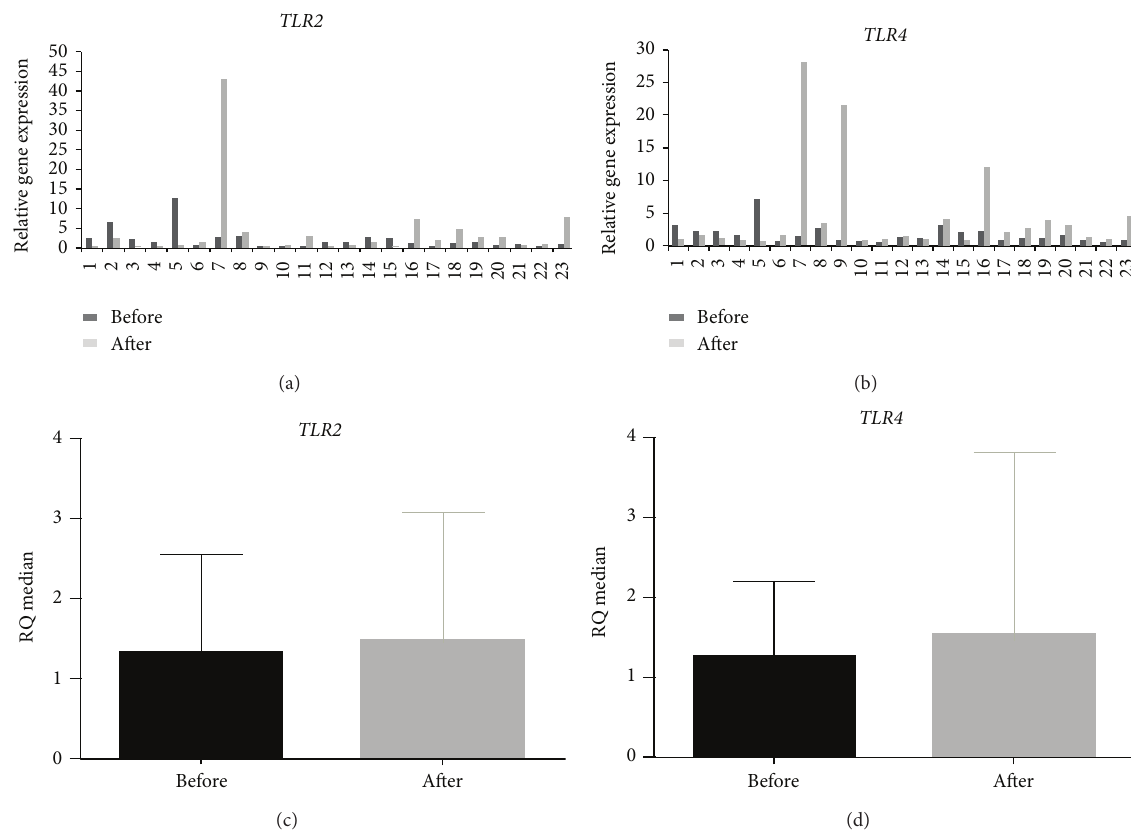
Figure 1: Relative expression levels of TLR2 and TLR4 RNAm in the eradicated patients group with chronic gastritis before and after H. pylori treatment. Relative quantification (RQ) of the mRNA expression levels of (a) TLR2 and (b) TLR4 per individual evaluated; RQ median of (c) TLR2 and (d) TLR4 mRNA before and after H. pylori eradication. Data are presented as median and range for experiments performed in triplicate. Statistical significance was determined using Wilcoxon’s signed rank